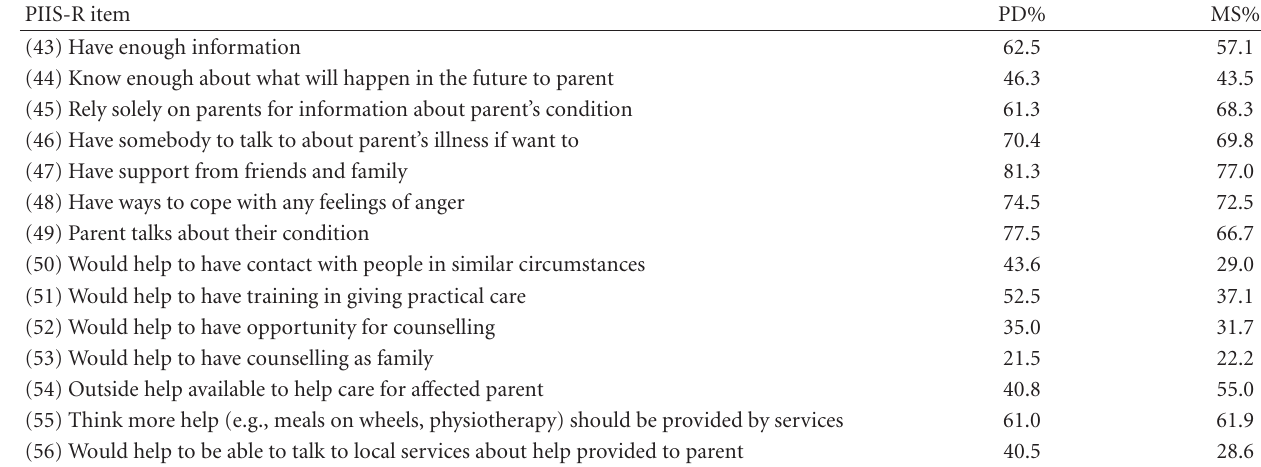
Table 3: Percentage values by parental condition for dichotomous variables of